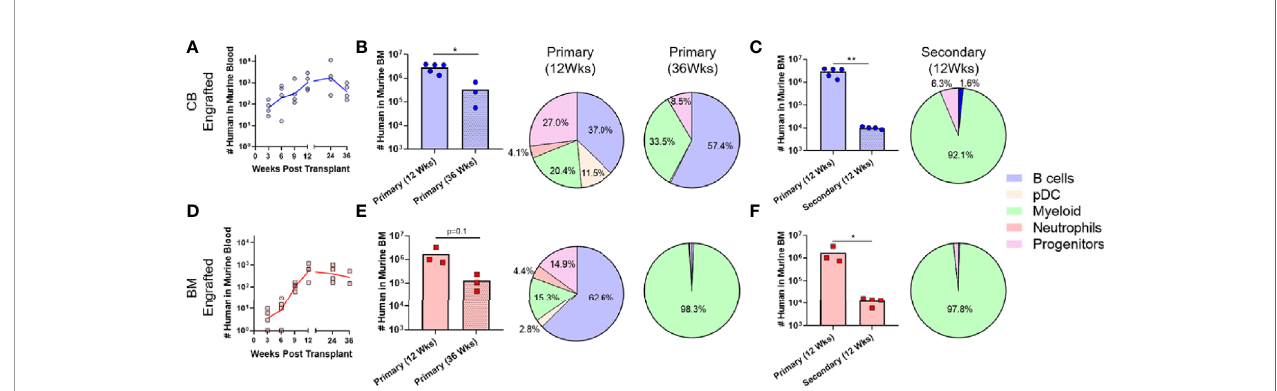
FIGURE 6 | Transplantation of CB-HSPCs produces a longer duration of multi-lineage engraftment than BM-HSPCs. Analyses were performed to evaluate the duration of the multi-lineage expansion produced by the initial HSPC transplantation as well as the ability of engrafted HSPC to re-populate a naïve host. (A) Blood draws were performed every 3 weeks on NBSGW given 2.5E 6 CB-HSPCs until week 12 after which they were performed every 12 weeks until 36 weeks. (B) Bar graph showing the total number of human cells in the bone marrow collected from one leg (femur + tibia) as determined by fl ow cytometry in mice 12 or 36 weeks post-transplant. The lineage composition of the human cells is shown as a pie graph. (C) Bone marrow collected from four mice initially transplanted with 2.5E 6 CB- HSPCs was combined and subjected to density gradient centrifugation, then 3E 7 mononuclear cells was transplanted into each of four naïve NBSGW mice. The number of transplanted HSPCs was approximately 2.5E 6 /mouse. The plot shows total number of human cells in the bone marrow collected from one leg (femur + tibia) at 12 weeks after primary vs. secondary transplant. Pie chart shows lineage composition at 12 weeks after secondary transplant. (D – F) Results from similar analysis using BM-HSPCs. Symbols show results from individual mice, and lines or bars show the geometric means. *p < 0.05; **p < 0.01.